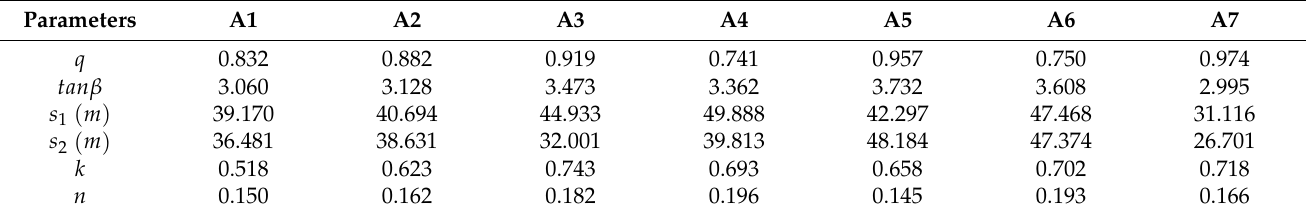
Table 5. Estimated CT-PIM